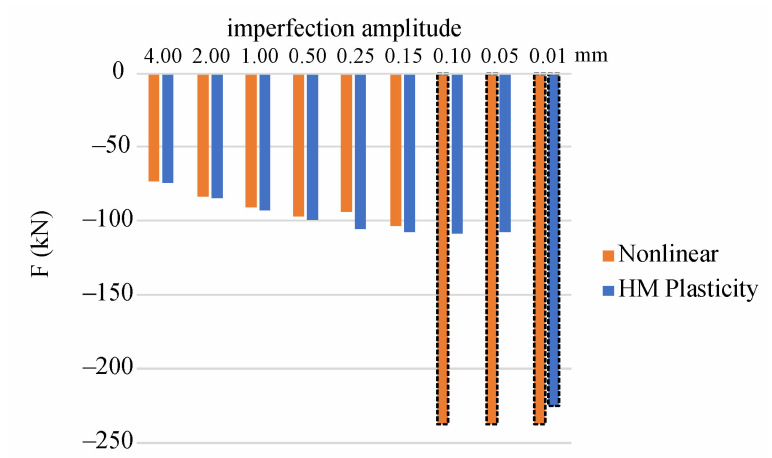
Figure 22. Critical force as a function of the initial amplitude of shape imperfection for the regarded constitutive models.